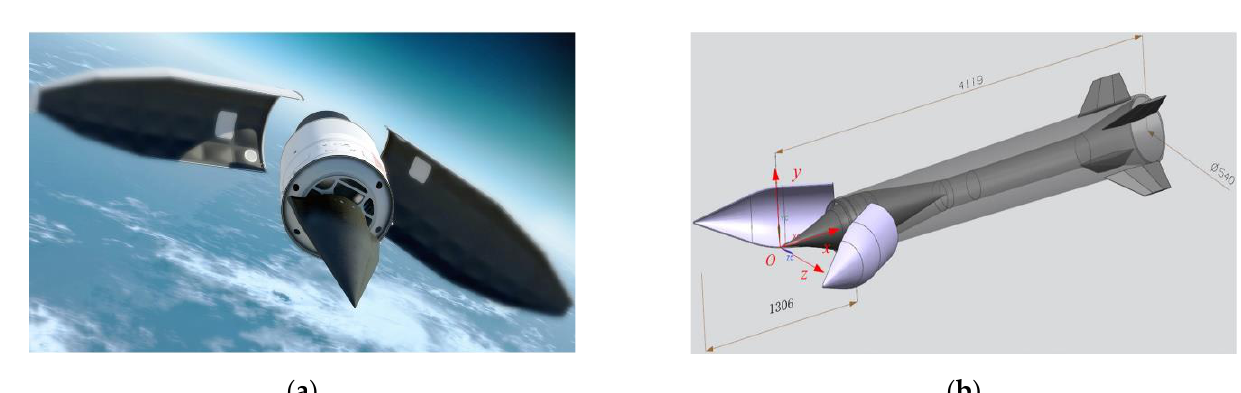
Table 2. Research status of shroud separation.